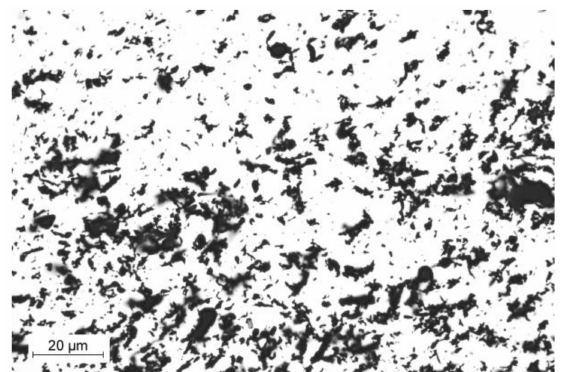
Figure 1. Image of aluminum (Al) powder taken using light